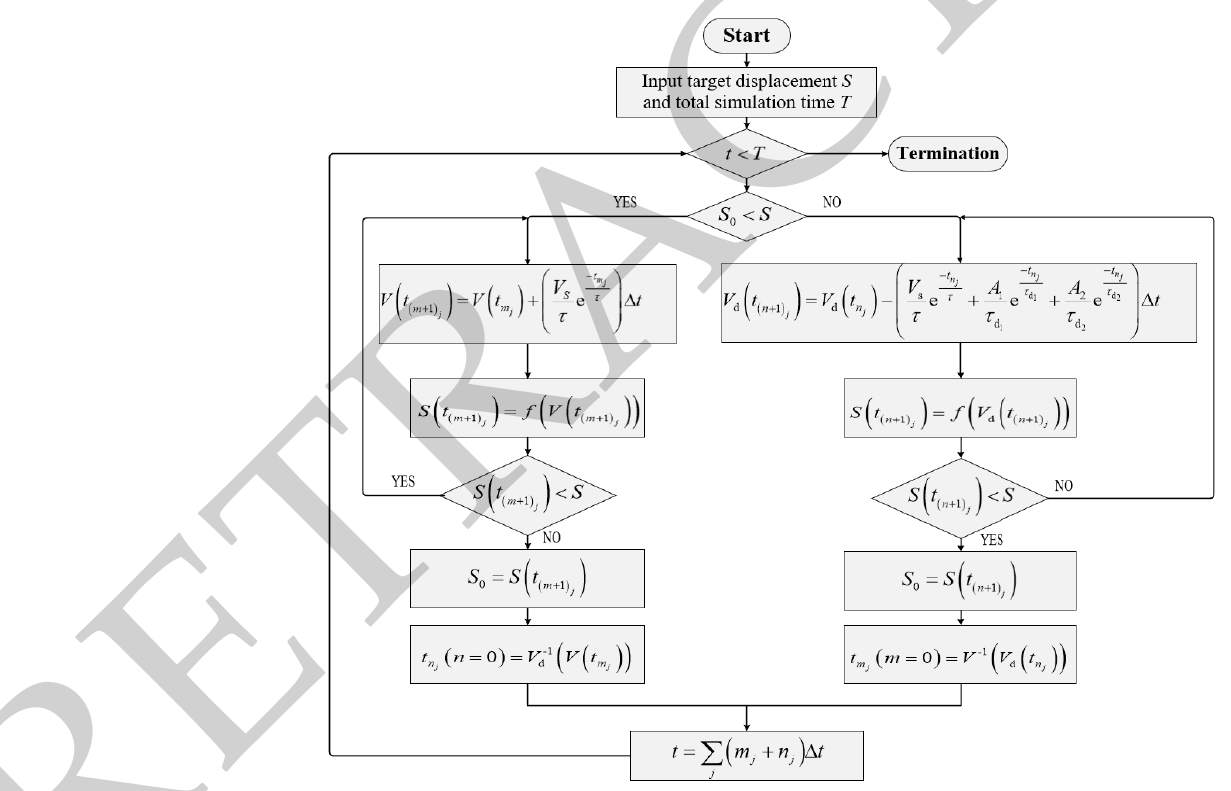
Figure 5. The flow sheet for the closed-loop displacement control of the hybrid actuator. On the basis of mathematical models and the flow sheet for the closed-loop displace- ment control of photovoltaic-electrostatic hybrid actuator, the closed-loop control equations of the displacement of the photovoltaic-electrostatic hybrid actuator based on the PLZT ceramic can be obtained as follows.